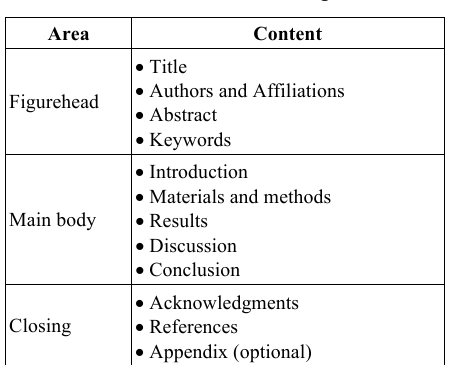
Table 1. Standard